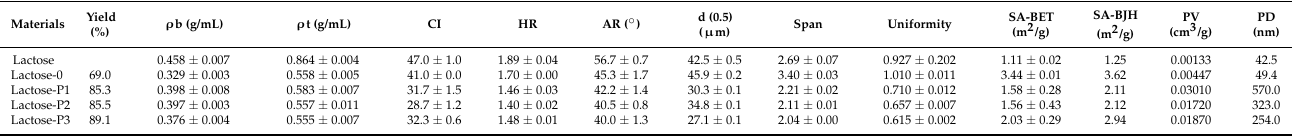
Table 1. The characterization of the materials studied in this